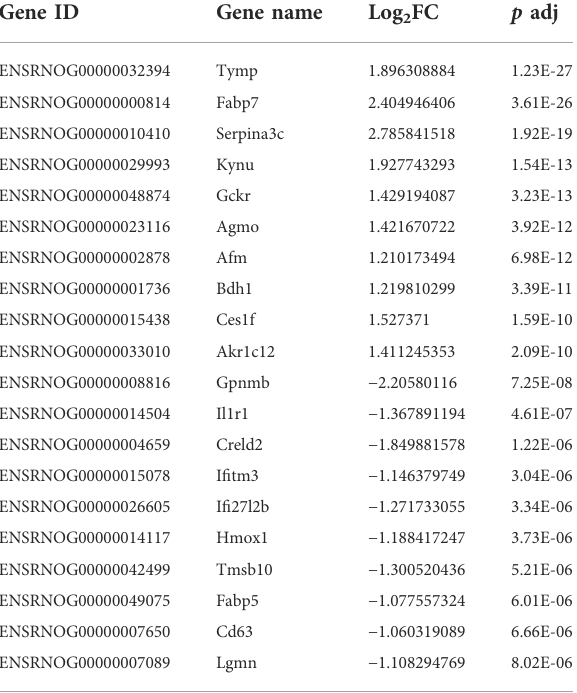
TABLE 3 The top 10 up- and down-regulated DEGs in